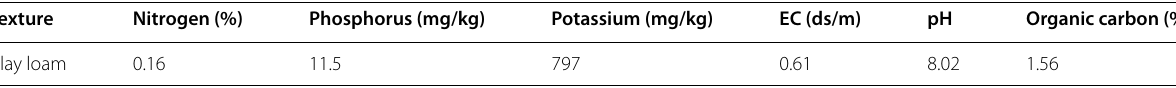
Table 1 Physical and chemical properties of field soil